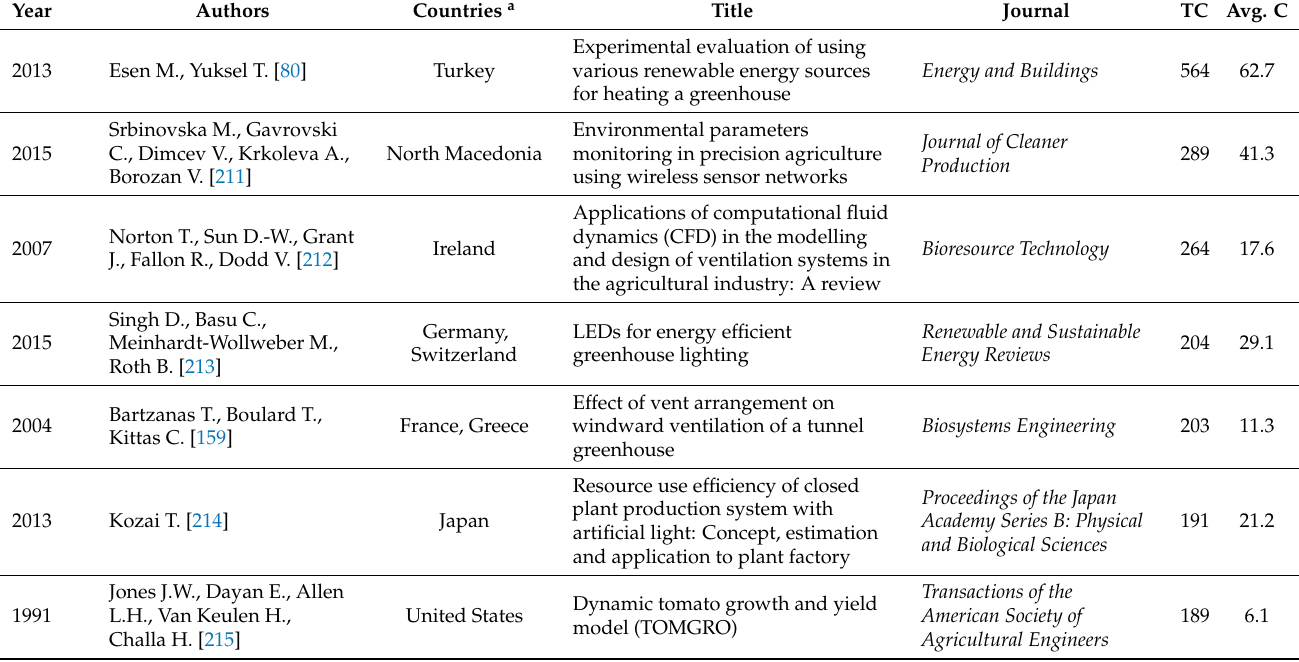
Table 3. Published papers that received more than a total of 130 citations and at least an average value of five citations per year (30 December